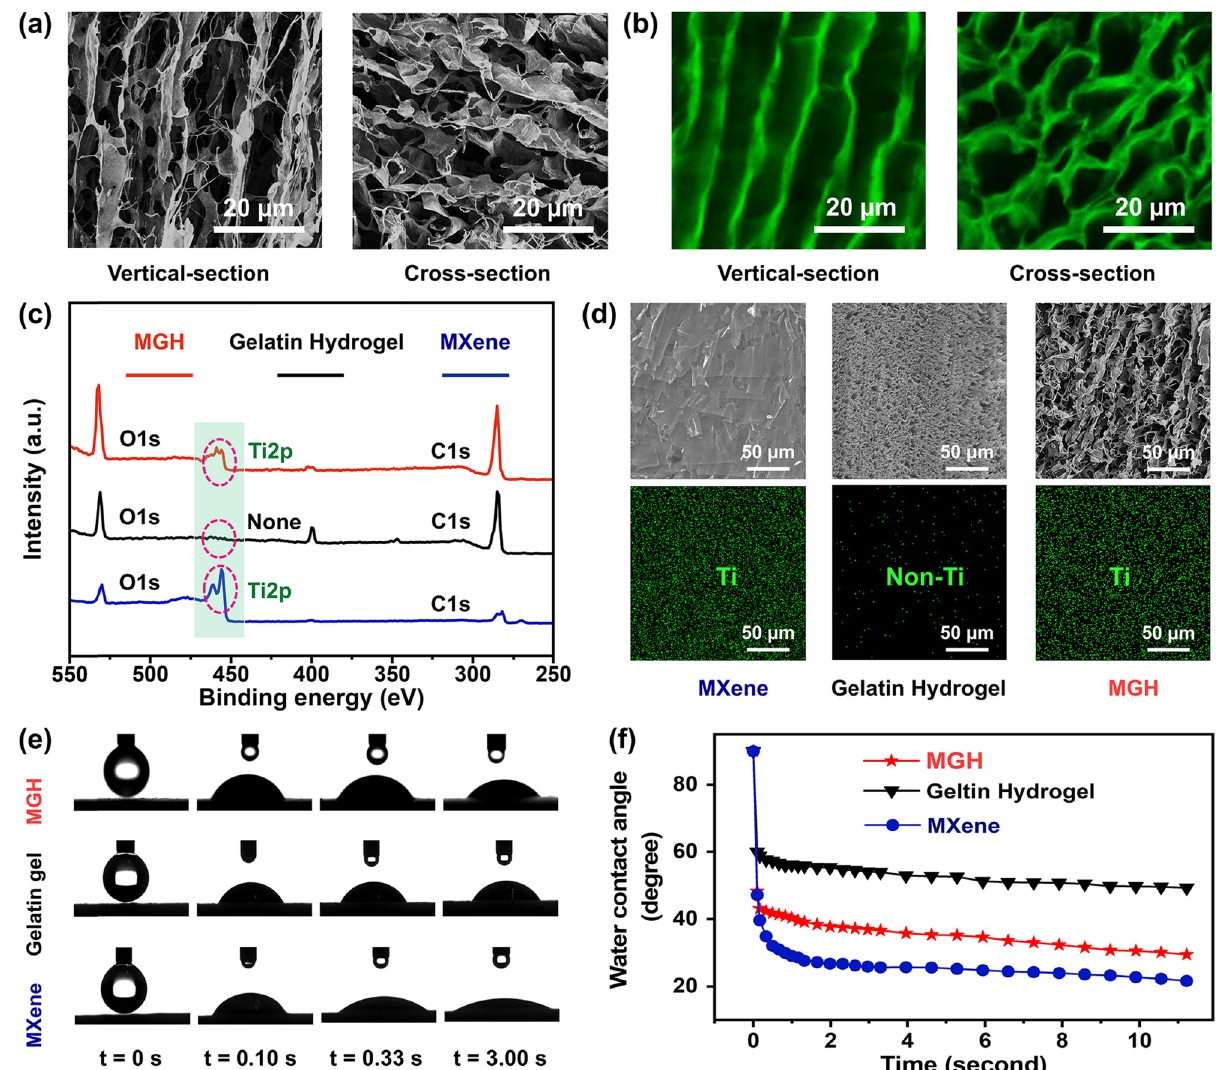
Figure 2: ( a ) SEM images of the vertical - section and cross - section of the MGH dry gel. ( b ) LSCM images of the vertical - section and cross - section of the MGH wet hydrogel. ( c ) XPS spectra of MGH, gelatin hydrogel, and MXene. ( d ) Ti element EDS mappings of MXene, gelatin hydrogel, and MGH. ( e and f ) The comparison of the water contact angle change between MGH and gelatin